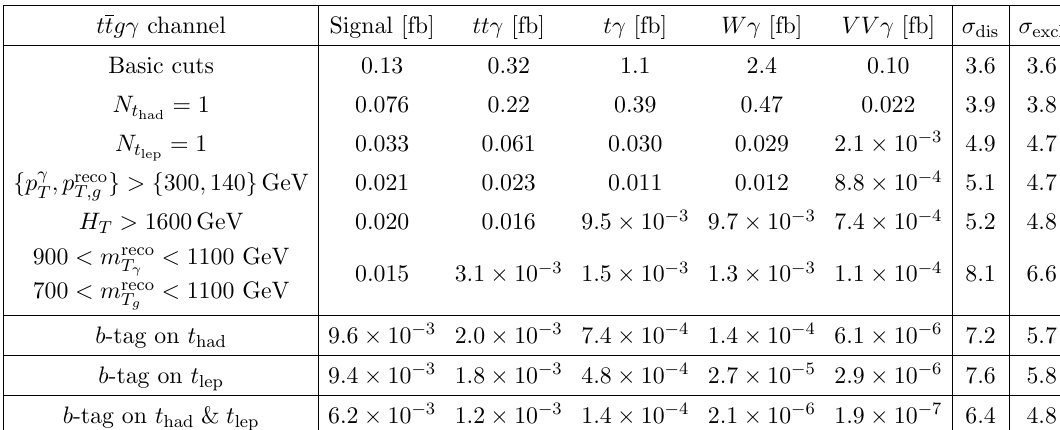
f p (cid:13) ; p reco g > f 300 ; 140 g GeV T;g T